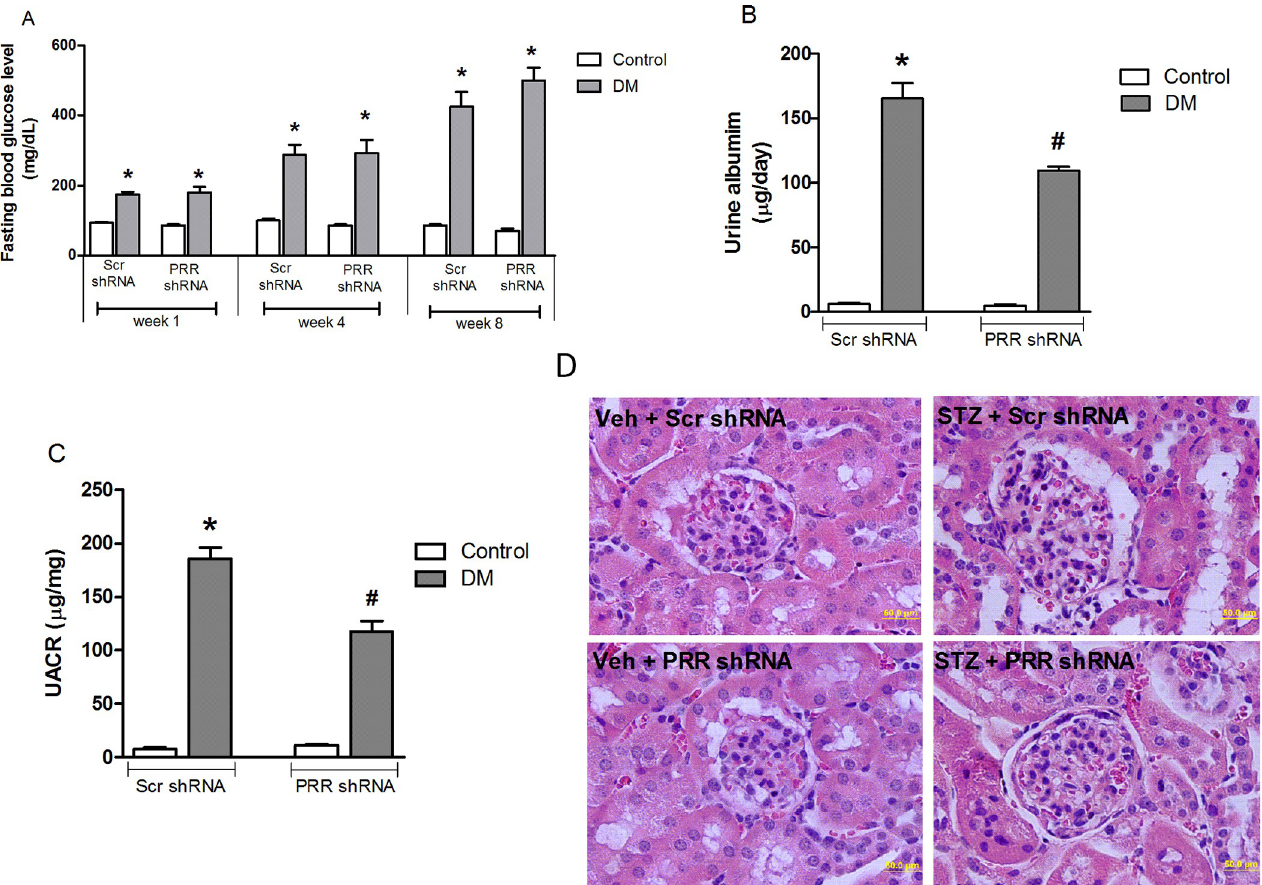
Fig 1. Fasting blood glucose levels in mice at weeks 1, 4 and 8 after diabetes induction. (A) 24-hour urinary albumin levels in mice (B) and urinary albumin to creatinine ratio (UACR) (C) in mice at the end of study (n = 8, each group). Representative images showing glomerular PAS staining in control and STZ- induced diabetic mice (D) treated with either scramble (Scr) shRNA or PRR shRNA respectively. Data presented as mean ± SEM, � P < 0.05 vs. Veh + Scr shRNA; #P < 0.05 vs. DM + Scr shRNA.